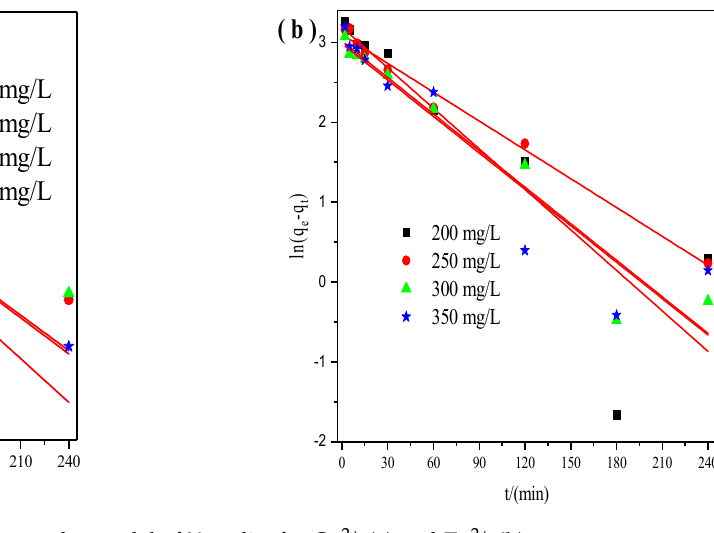
where k 2 (min − 1 ) is the rate constant of pseudo-second-order reaction and h [mg/(g·min)] is the initial sorption rate. The rate constants can be determined via the linear plot t/q t against t (Figure 3). Figure 2. Pseudo − first order model of X zeolite for Cu 2+ ( a ) and Zn 2+ ( b ). The pseudo − second order model was displayed in the following format [31]: